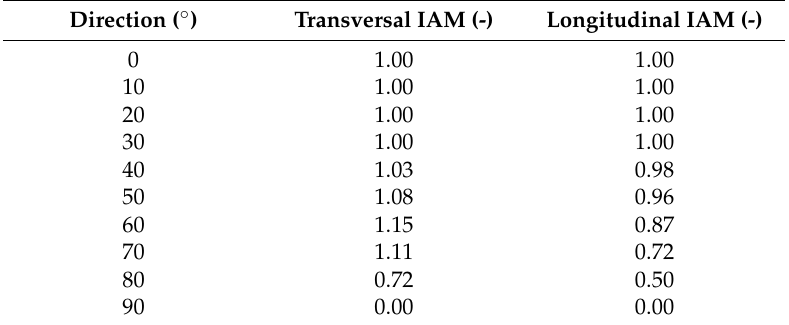
Table 4. Evacuated tube collectors incident angle modifier (IAM)